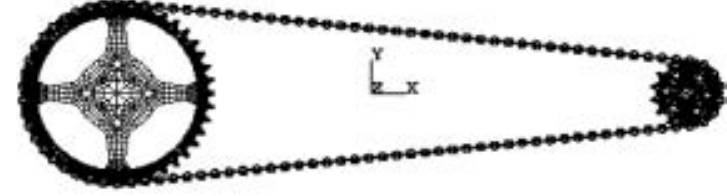
Fig. 4. The simple FE model of the chain drive.